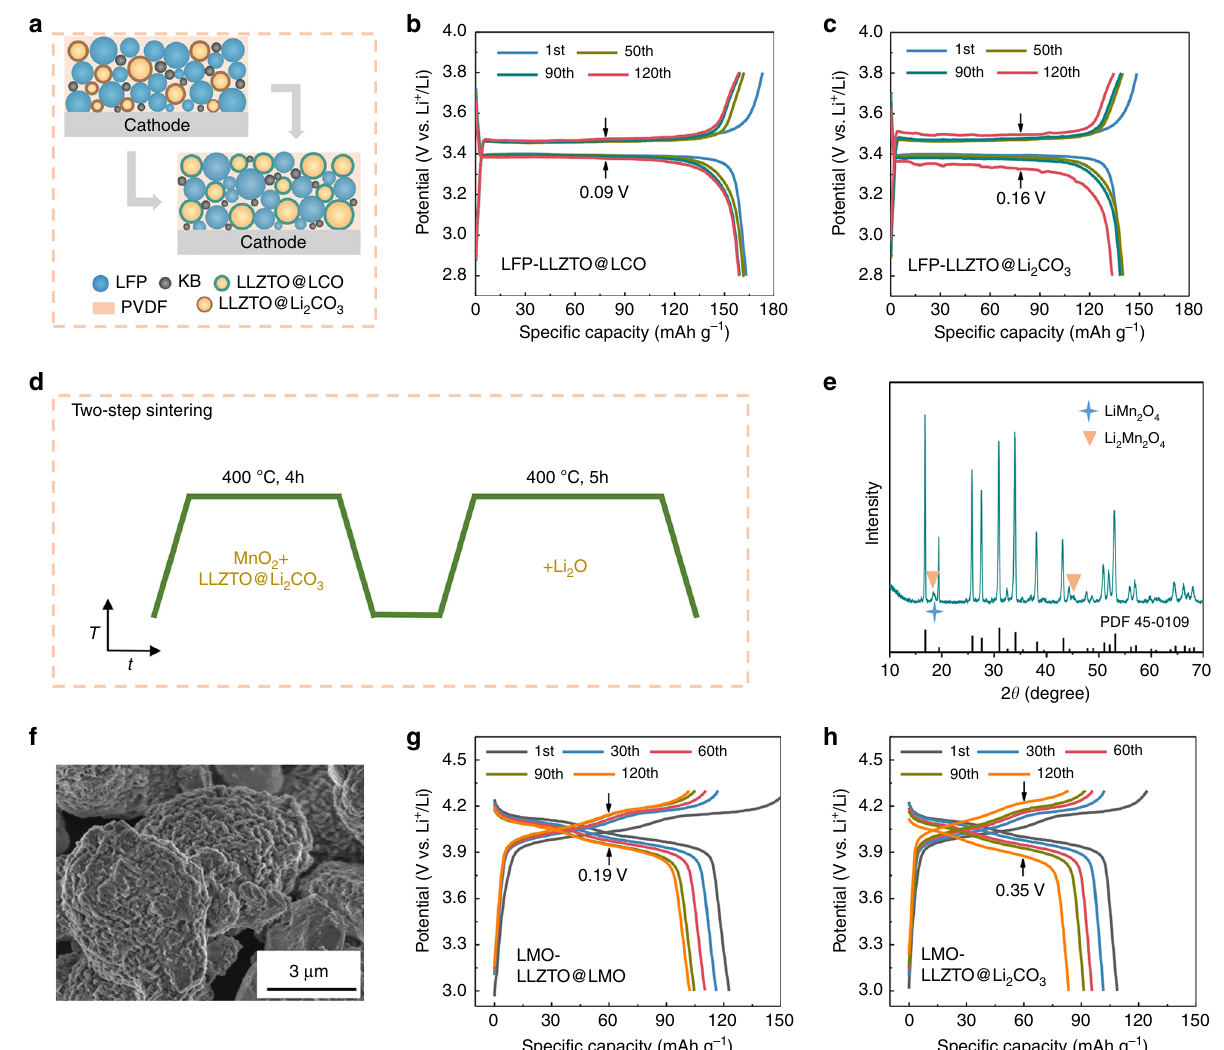
Fig. 7 Extensive applicability of LLZTO@active-material and the two-step solid state reaction. a Schematic illustration of the LFP-LLZTO@Li 2 CO 3 and LFP-LLZTO@LCO composite cathodes. b , c Discharge/charge curves of the SSBs with an LFP-LLZTO@LCO and LFP-LLZTO@Li 2 CO 3 composite cathode, separately. d Schematic illustration of the two-step solid state reaction. e , f SEM image and XRD pattern of the ultimate materials after converting Li 2 CO 3 into LMO. g , h Discharge/charge curves of the SSBs with an LMO-LLZTO@LMO and LMO-LLZTO@Li 2 CO 3 composite cathode,